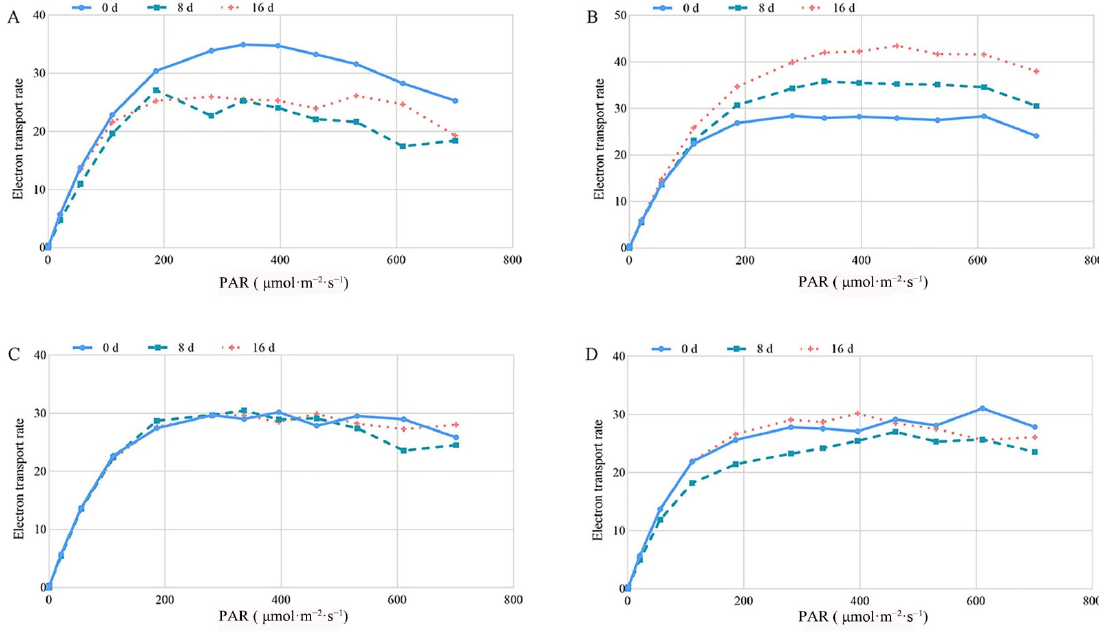
Figure 4. Effect of exogenous MT on ETR. The tea plants were exposed to control ( A ), 0.2 mM MT ( B ), 0.3 mM MT ( C ), and 0.4 mM MT ( D ).